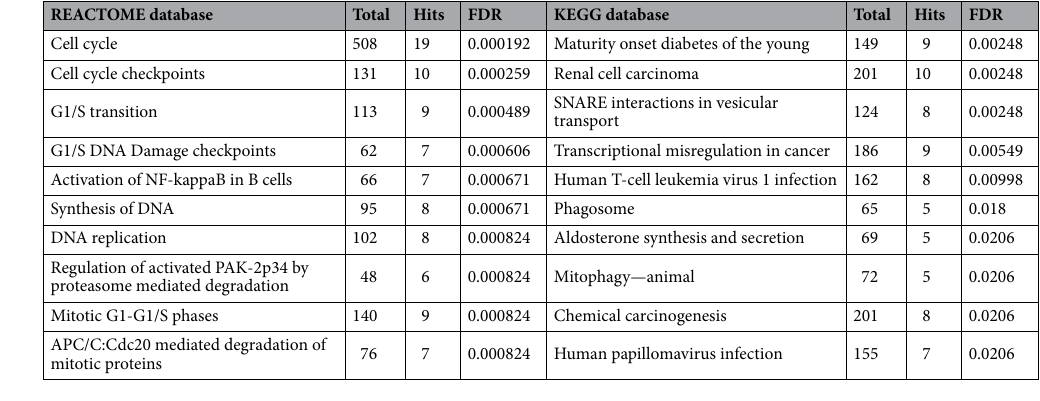
Table 1. Pathway enrichment analysis of the dysregulated proteins by simulated diabetes.